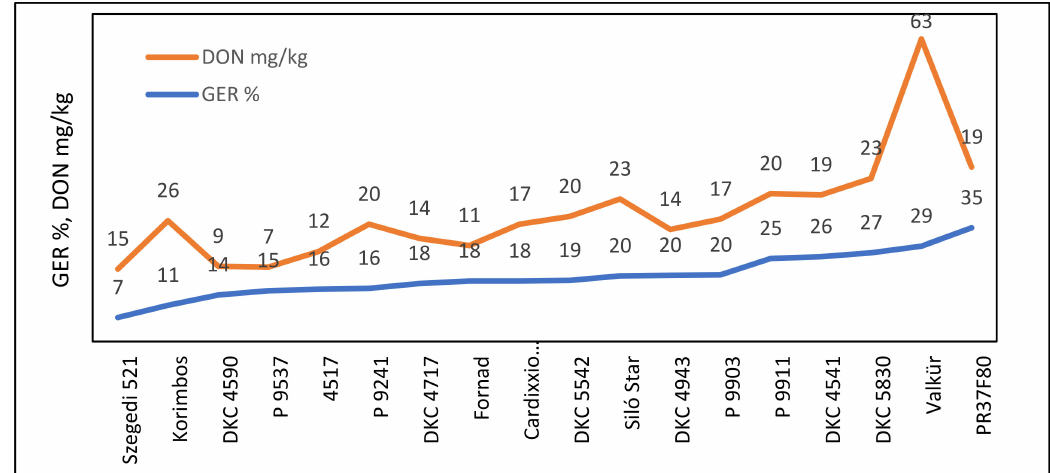
Figure 1. F. graminearum kernel ear rot percentage and DON contamination in 2017–2018. The LSD 5% value for DON is 15.52. For Valkür, the corresponding data point on the regression line is 27.70. Adding this to the LSD 5% value of 15.52 resulted in 43.21. Valkür had 63.28 mg/kg DON, 20.07 mg/kg more than the 43.21 mg/kg, so it is a DON overproducing hybrid. Variances for DON can be found for each data point in Table S2.